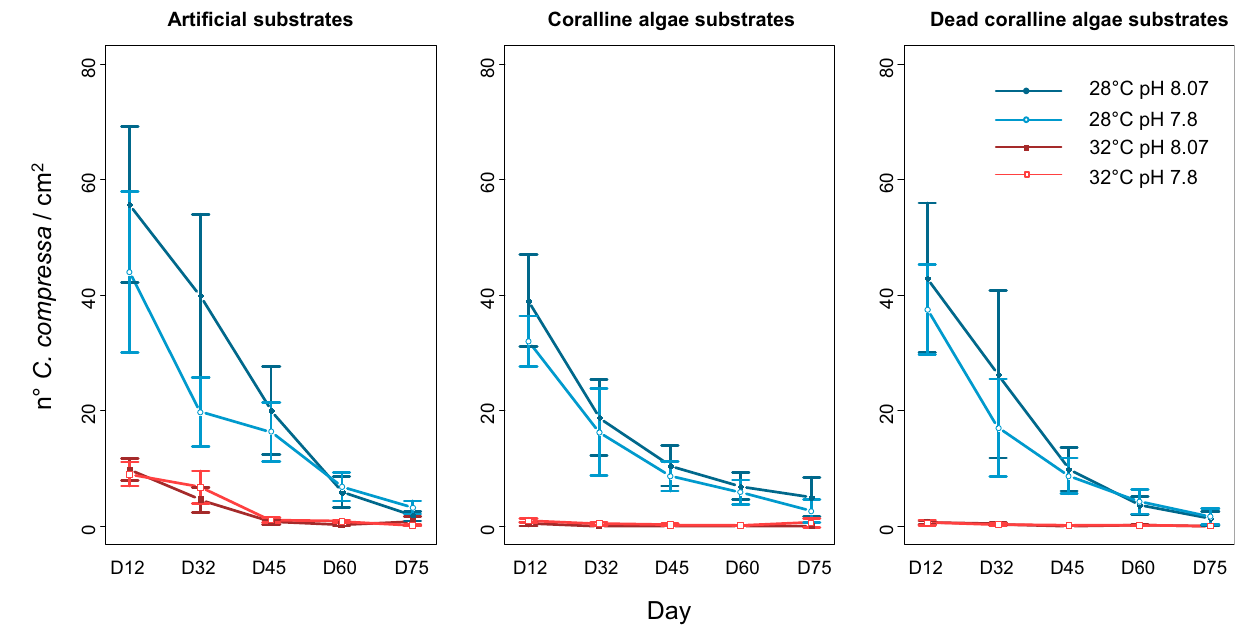
Figure 3. Densities of recruits on living and dead Neogoniolithon brassica-florida and on artificial substrates, as a function of temperature and pH under the different treatments. The errors bars show the confidence intervals.